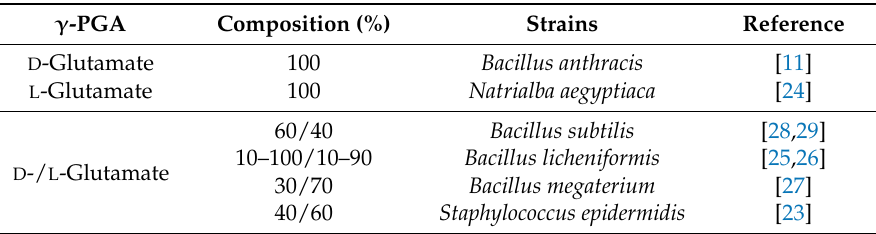
Table 1. D / L forms of γ -PGA-producing strains.